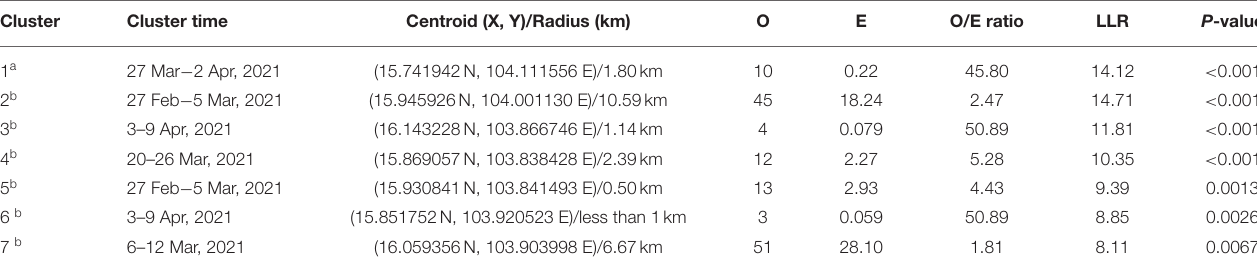
TABLE 4 | Spatio-temporal clusters by space-time permutation model on lumpy skin disease outbreaks in cattle farms in Roi Et, Thailand 2021.